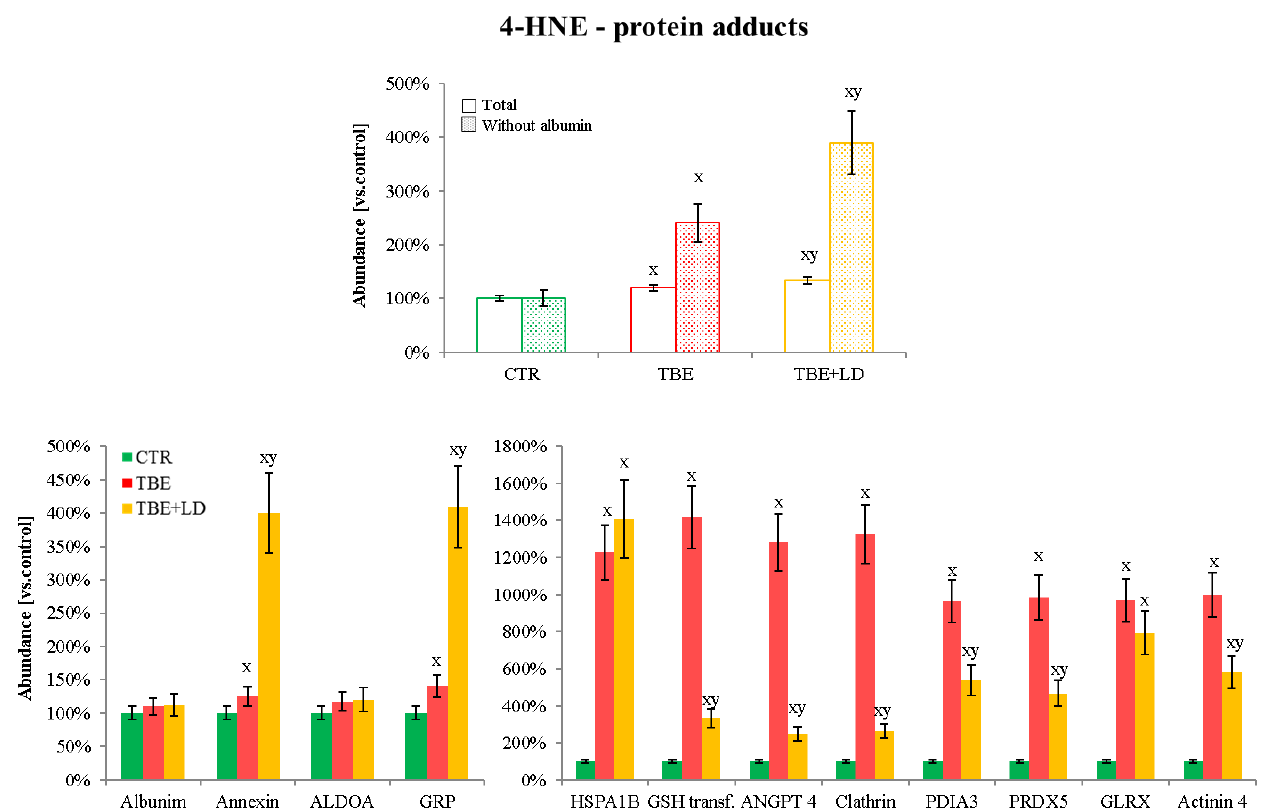
Figure 7. The level of protein modification by 4-hydroxynonenal (4-HNE) in the plasma samples of the control group (CTR, n = 8), patients with tick-borne encephalitis (TBE, n = 16), and patients with TBE and co-infection (TBE+LD, n = 5). Mean values ± SD are presented. x statistically significant differences vs. CTR, p < 0.05; y statistically significant differences vs. TBE, p < 0.05.